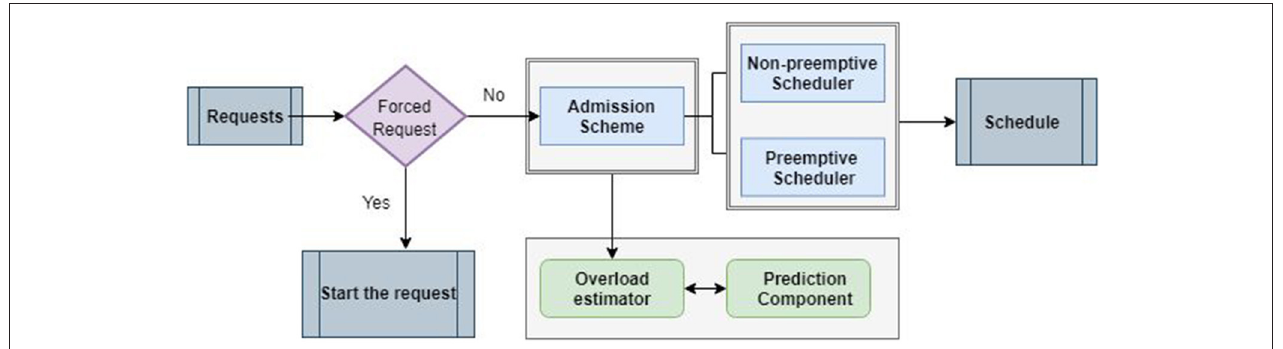
FIGURE 2 | General architecture of the proposed